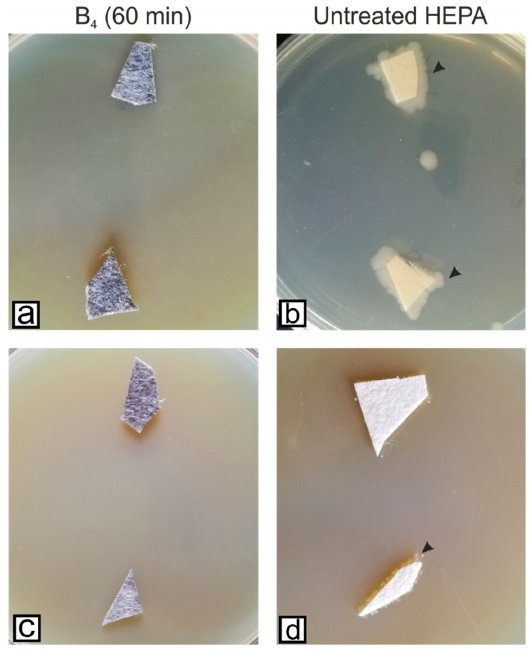
Figure 6. SEM micrographs of HEPA filters modified with 2 mg/mL Gr-Ag (5 wt% Ag) hybrid (asterisk) for 60 min and incubated with E. coli ( a , b ) and S. aureus ( c , d ) for 24 h at 37 °C; black ar- rowheads indicate the presence of bacteria on the fibers; bare HEPA filters ( b – d ) .